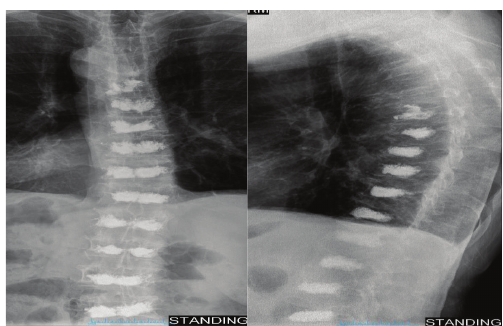
Figure 1: AP and lateral X-rays taken of the thoracic spine following the last of the eleven kyphoplasties. The patient underwent two kyphoplasties of T8 and one each of T9–T12.